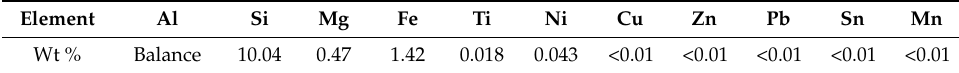
Table 1. The chemical composition of the AlSi10Mg